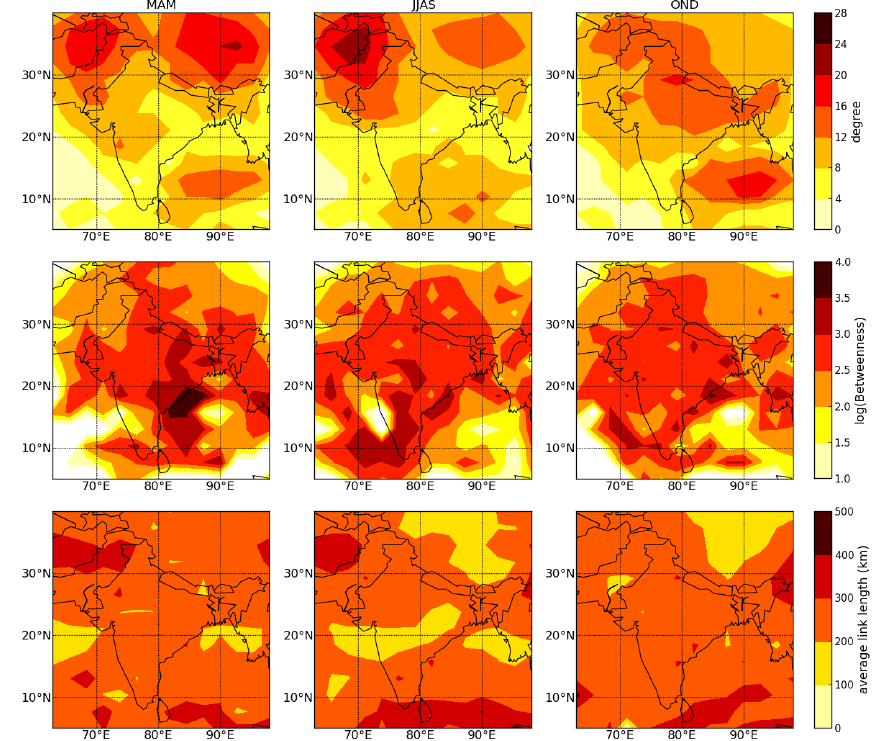
Figure 9. Network measurements for the three time periods: pre-monsoon (MAM), monsoon (JJAS), and post-monsoon (OND) pressure networks. From top to bottom: degree, betweenness, average geographical link lengths (NCEP/NCAR